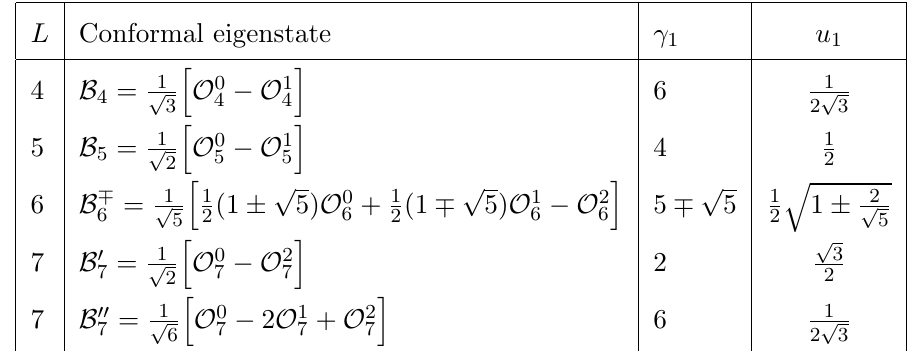
, and indicate their anomalous dimension L